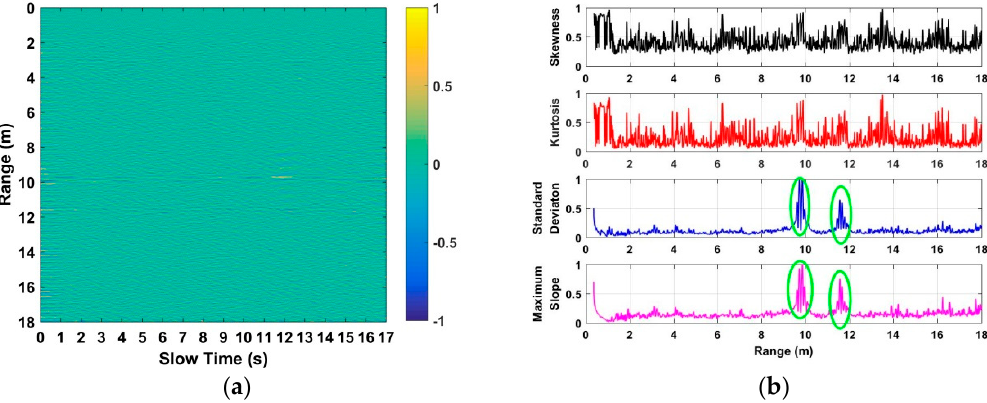
Figure 18. Results of the detection of two targets ( a ) after removing clutter; and ( b ) distance estimates.